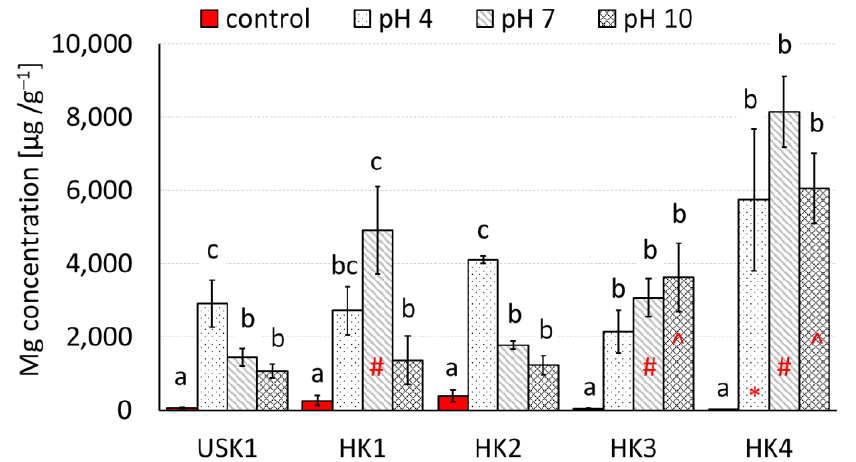
Figure 4. Mg accumulation (mean ± SD; µg g −1 in the biomass of bacterial strains isolated from the phosphate ore (HK1 – HK4 strains) and B. subtilis USK1 reference strain, after incubation (20 min; 28 °C; pH 4 or 7 or 10) with the ore from Djebel Onk. The same letter (a, b, c) in a particular strain denotes no significant differences among pH groups. The red marks indicate the differences between each native strain and the reference strain USK1 at pH4 (*), pH7 (#), and pH10 (^) analyzed separately (ANOVA, LSD; p < 0.05).